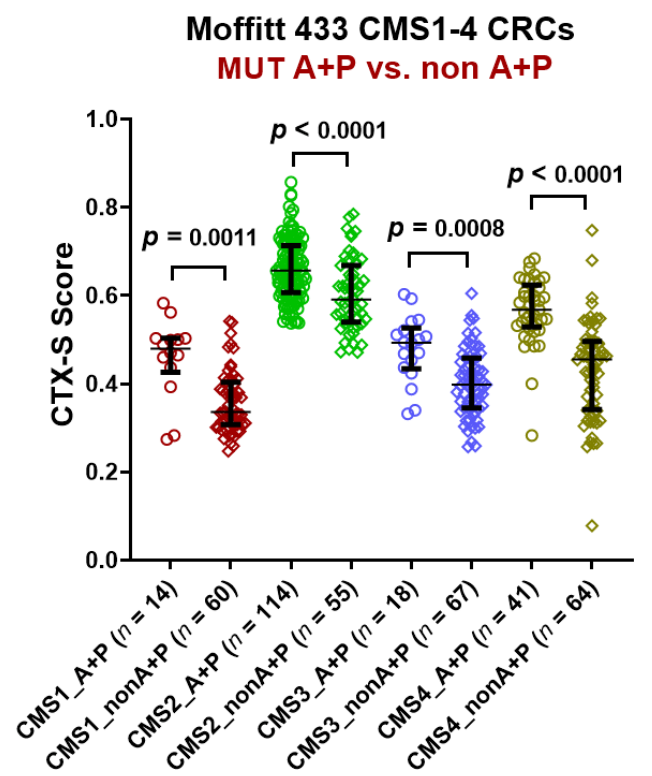
Figure 2. Comparison of CTX-S scores in MUT A + P vs. nonA + P in each of four CMS classes in Moffitt 433 CMS1-4 CRC tumors. Here, A—MUT APC ; P—MUT TP53; MUT A + P represents tumors harboring combined APC + TP53 mutations regardless of RAS/RAF mutation status. nonA + P represents tumors without combined APC and TP53 mutations. Bars represent median with interquartile range. p values are for two ‐ tailed Welch t test.